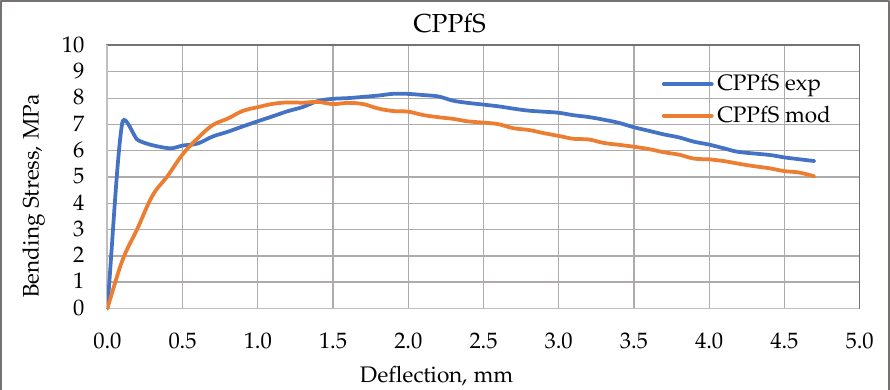
Figure 6. Experimental and modelling data comparison for the group CPPfS.